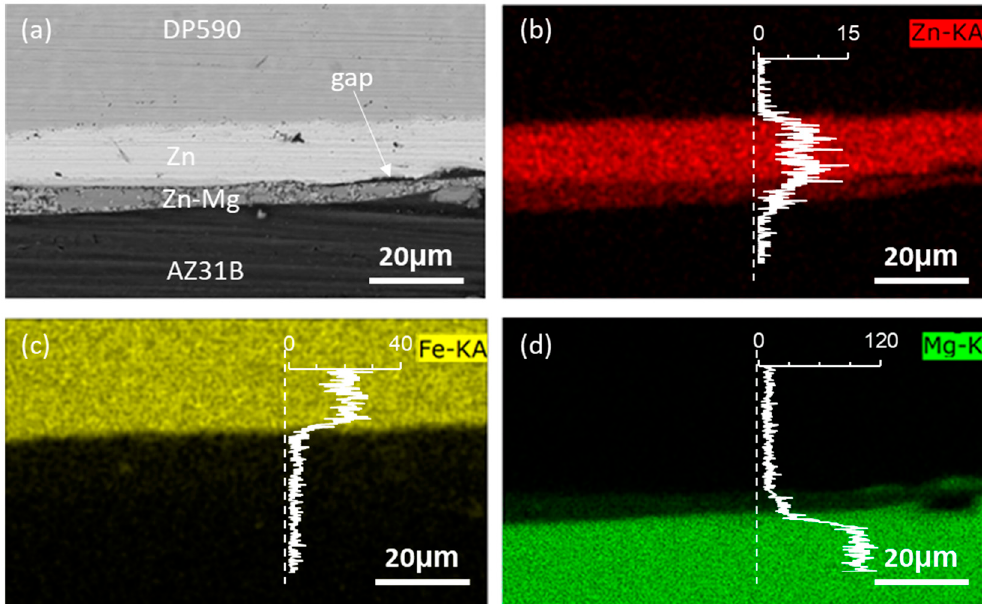
Figure 6. Morphology and chemical composition at the center of the joint interface on welds produced with low welding energy (Experimental Setup 1 condition as listed in Table 1). ( a ) SEM image of the bonding interface between DP590 and AZ31B, and the element maps in the same region: ( b ) Zn, ( c ) Fe and ( d ) Mg. The inserted line plots represent the quantification of each composition along the dashed line. The unit of the horizontal axis is in count.